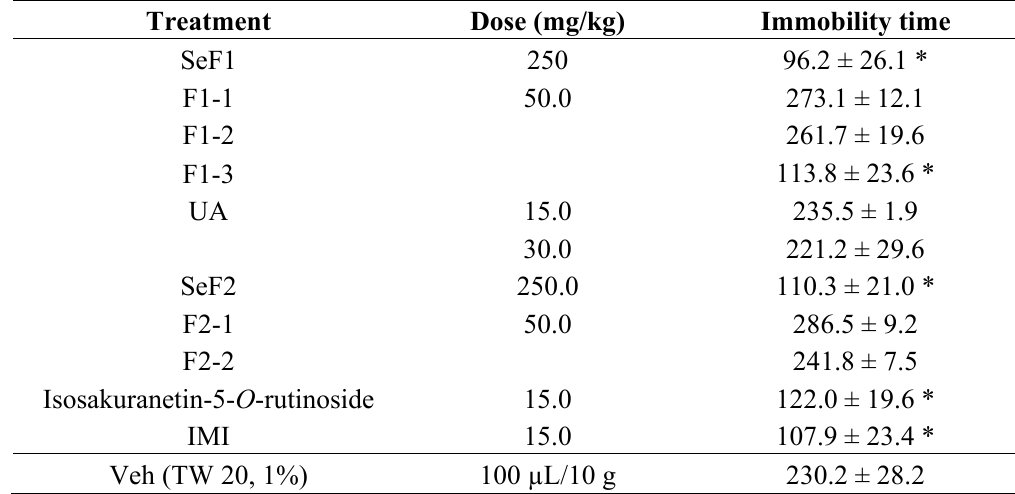
Table 1. Effect produced by different fractions and compounds separated from SeF1 and SeF2 on immobility time in